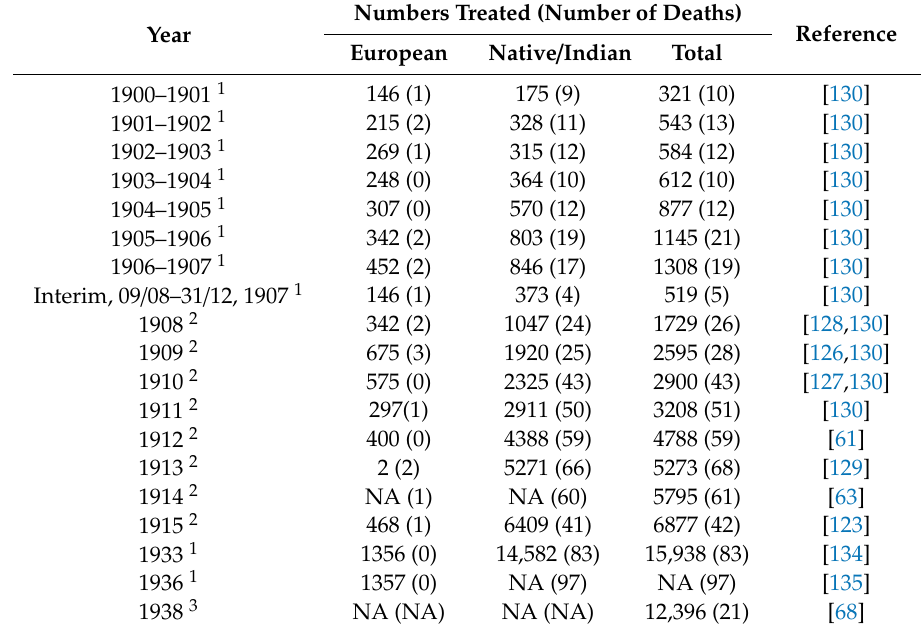
Table 1. Number of people given rabies post-exposure prophylaxis at various Pasteur Institutes in India. Category totals may not always match as the breakdown of the number of patients treated and the number of deaths was not always explicitly